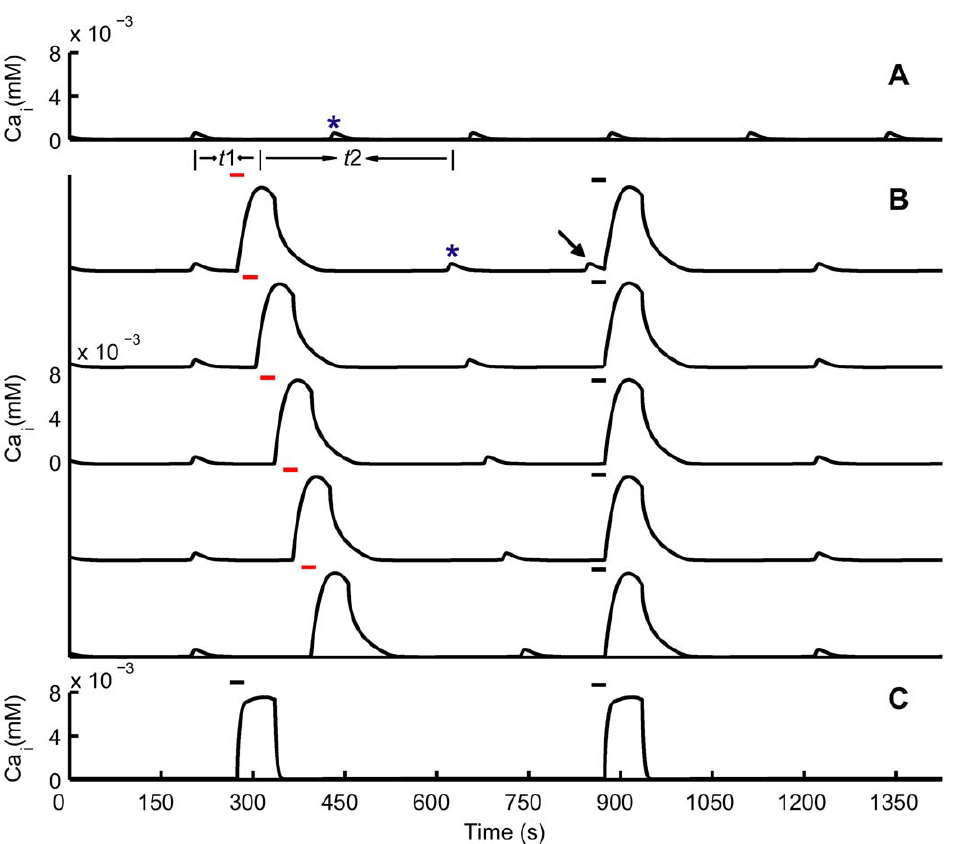
Figure 5. Interactions between CASs and CSDCWs. (A) A series of CASs occur without any stimulus. (B) The appearance of CSDCWs depresses CASs, and CASs reappear a few minutes after the pass of CSDCWs (the affected CASs are marked with asterisks in A and B). CSDCWs can appear immediately after CASs (marked with an arrow in B). By regulating the appearance time of CSDCWs through changing the time points of locally elevating K o (marked with red bars in B), the peak-to-peak interval between the CSDCW and the following CAS is similar, and it is not related to the peak-to-peak interval between the CSDCW and the previous CAS. t 1, the peak-to-peak interval between the CSDCW and the previous CAS. t 2, the peak-to-peak interval between the CSDCW and the following CAS. (C) Depletion of Ca 2 + stores in the ER abolishes CASs, but CSDCWs still spread. The bar illustrates the time of locally elevating K o